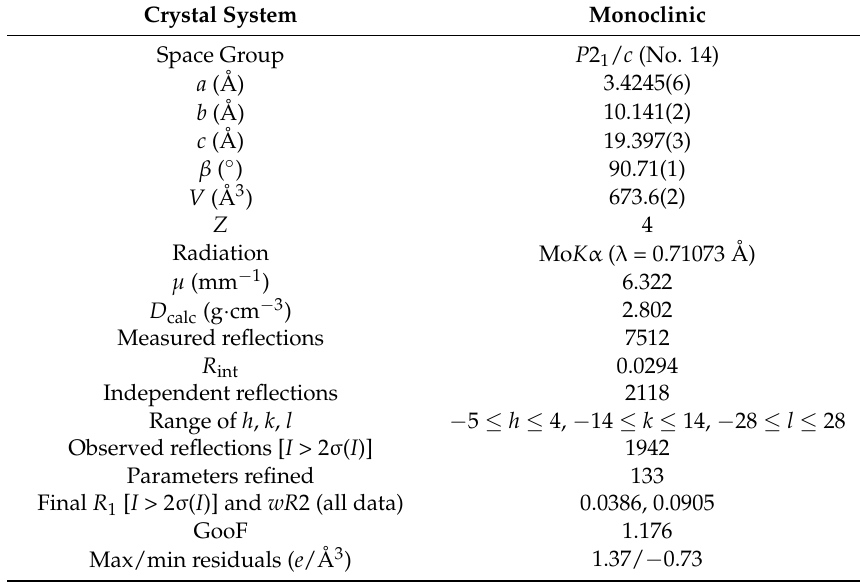
Table 3. Single-crystal diffraction data and refinement parameters for fiemmeite.